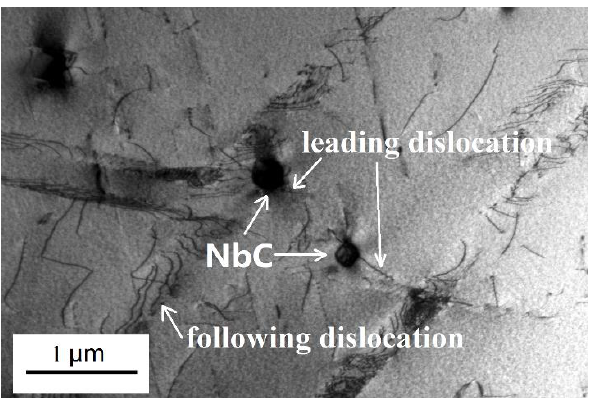
Figure 13. Interaction between dislocations and precipitates in 0.5Nb low density steel at 5% strain.